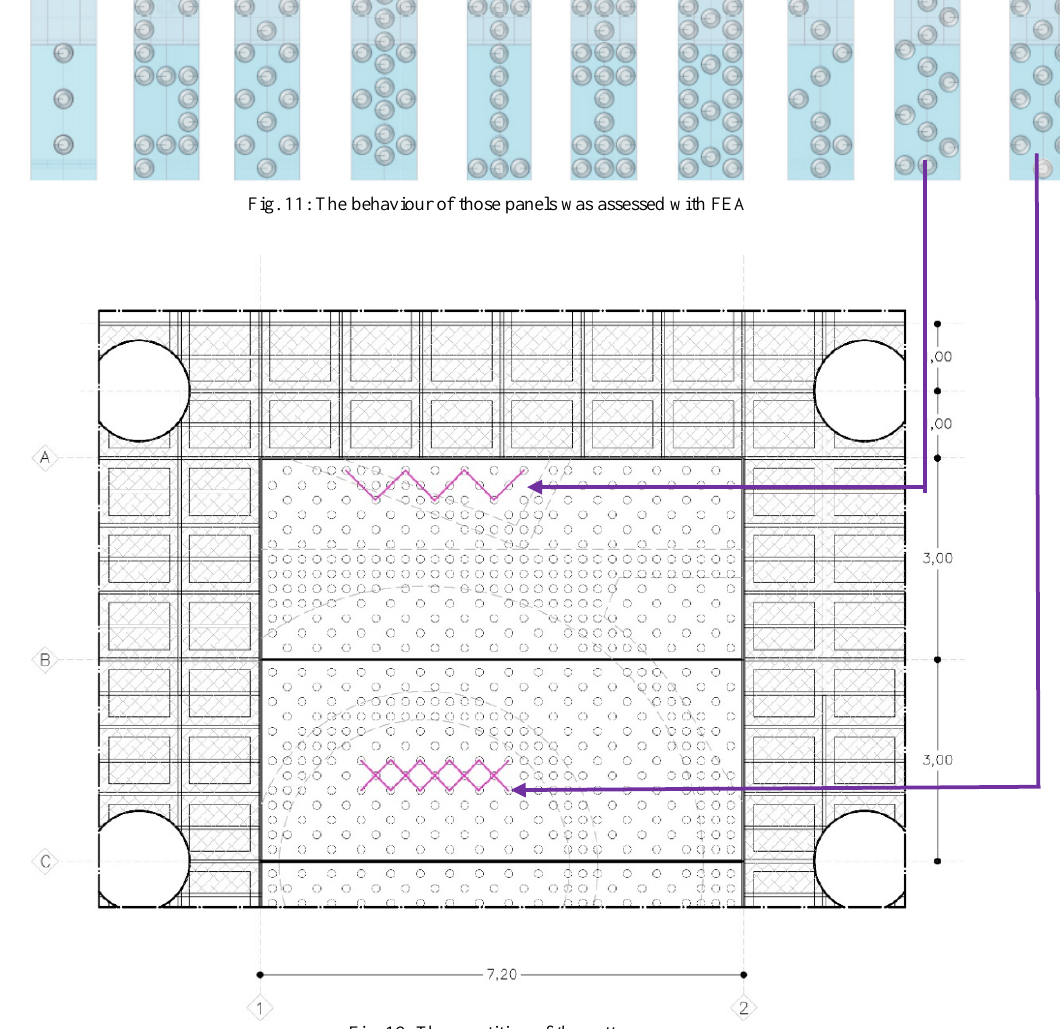
Fig. 12: The repetition of the